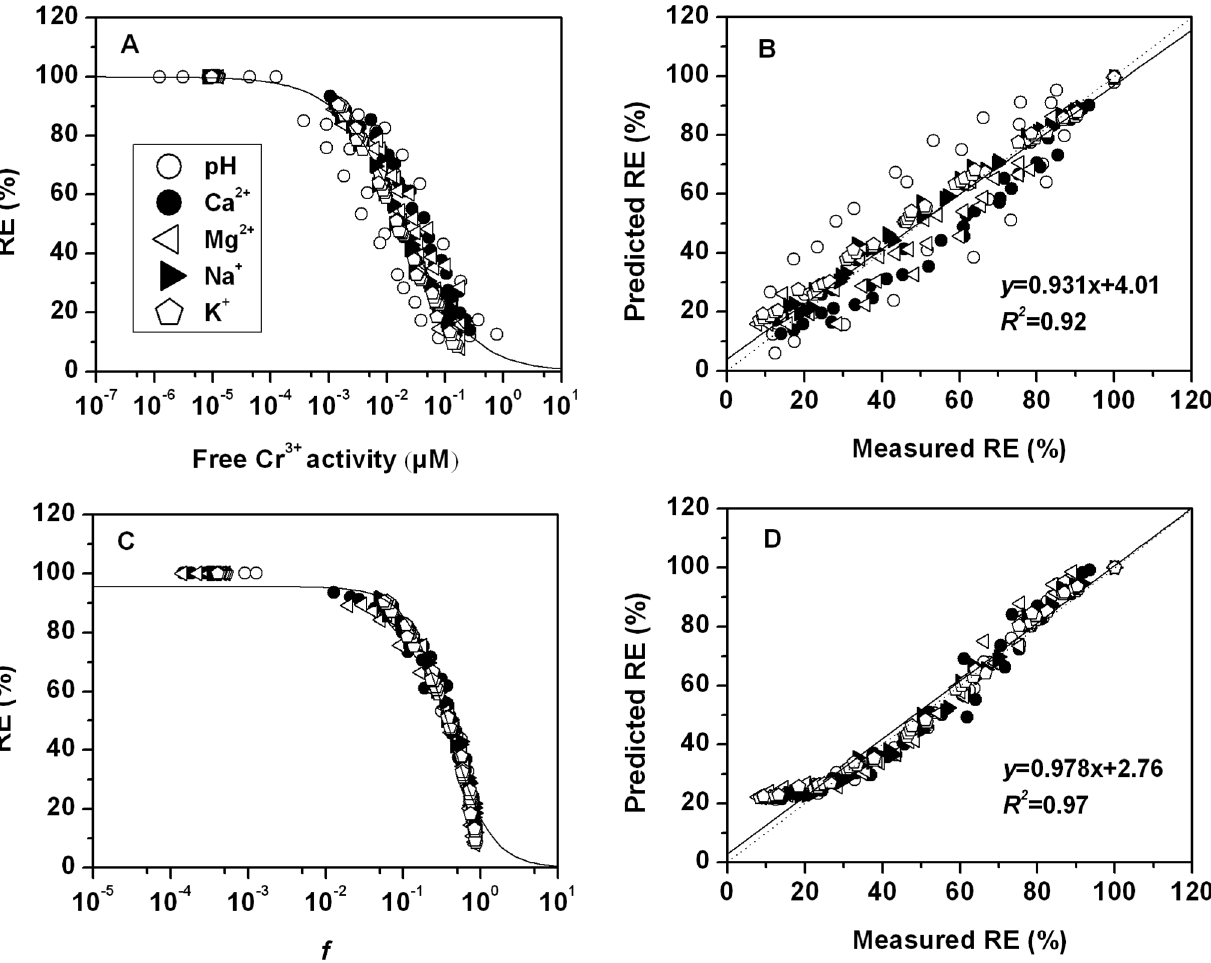
Figure 3. Toxicity of Cr to barley root elongation expressed as different dose–response curves: the dose as free Cr 3 + activity only (A), as the fraction ( f ) of the total biotic ligand sites occupied by toxic Cr 3 + and CrOH 2 + considering the competitive effect of Ca 2 + and Mg 2 + activity (C). The measured versus predicted root elongation based on FIAM(B) and BLM(D).The dotted lines are 1:1 lines and the solid lines represent the linear regression relationships between the measured and predicted barley root elongation. The lines are the fitted logistic curves based on all sets.